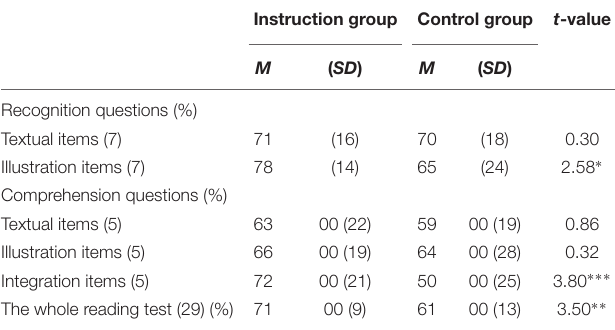
TABLE 2 | Accuracy on the reading test for instruction ( N = 31) and control ( N = 31)